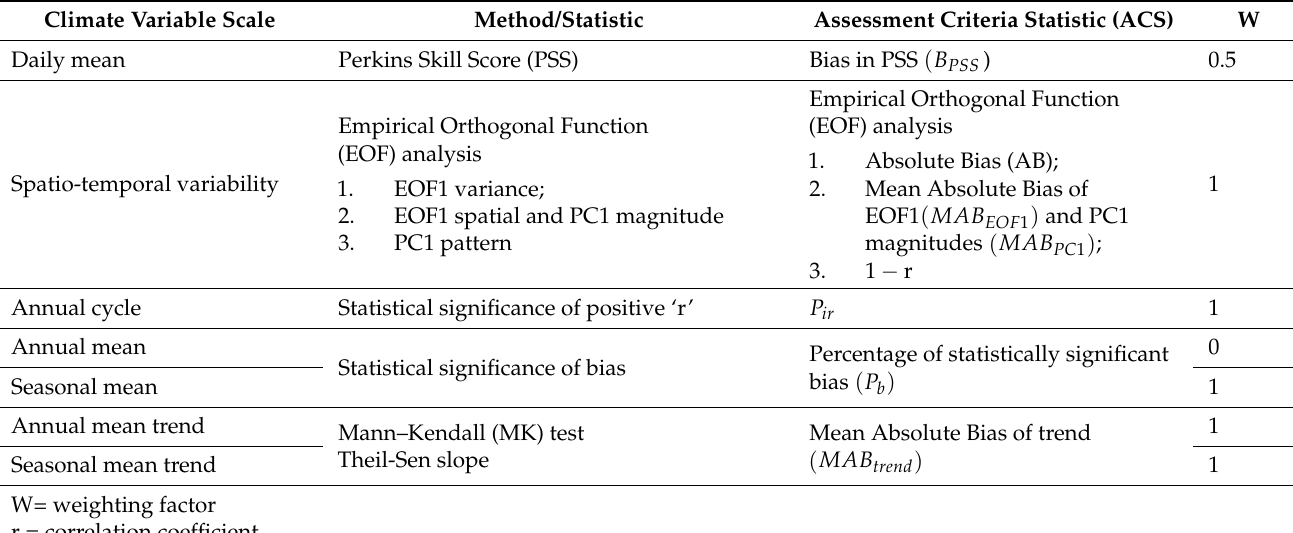
Table 3. Summary of assessment criteria statistics used to evaluate models at various climatic variable scales. Climate Variable Scale Method/Statistic Assessment Criteria Statistic (ACS)